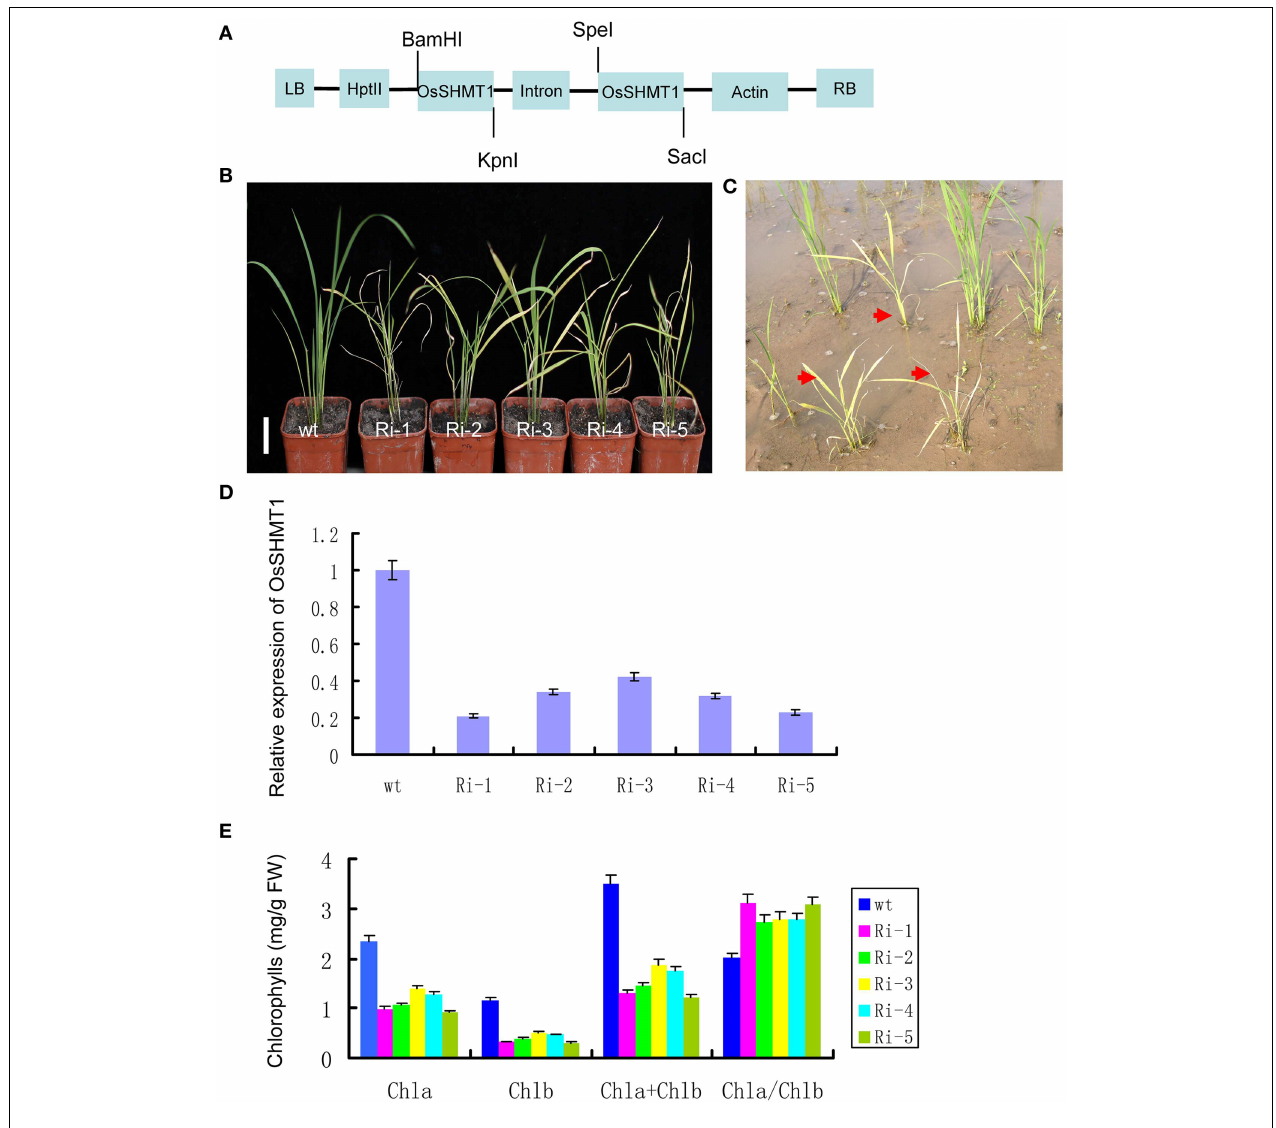
analyses of OsSHMT1 expression in wild type (WT-1 and -2) and five independent RNAi lines (Ri-1–5). The results indicate that the expression of OsSHMT1 in the five independent RNAi lines had decreased to some extent. The experiments are biological replicates with the SD. (E) The pigment contents in the leaves of wild-type plants and independent complemented lines (Ri-1–5) were